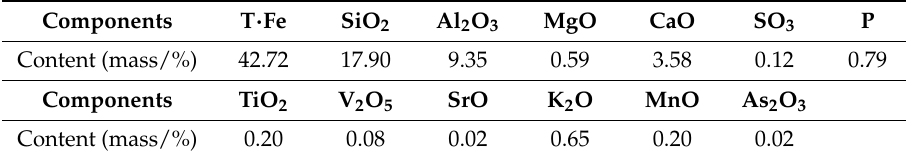
Table 1. Chemical analysis results of high-phosphorus oolitic